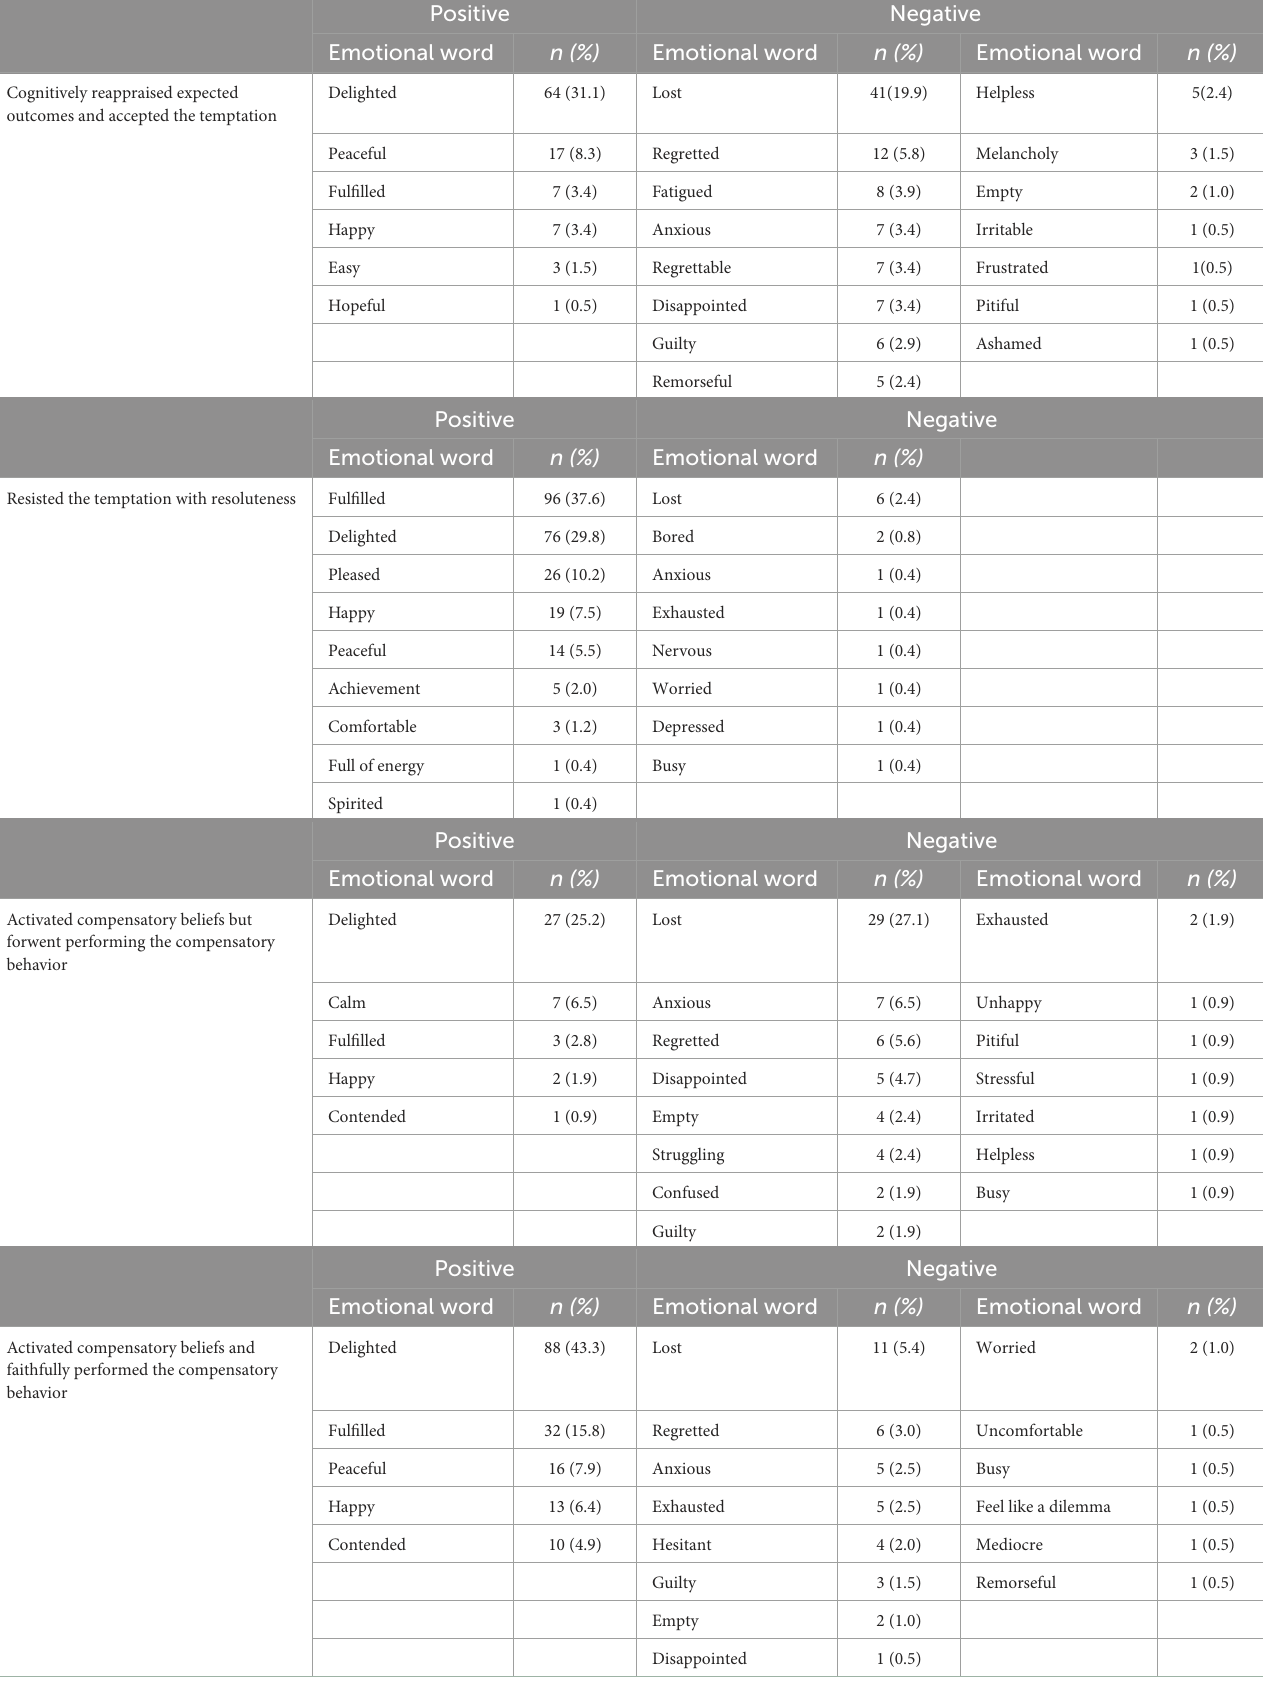
TABLE 3A Emotional word coding table (college